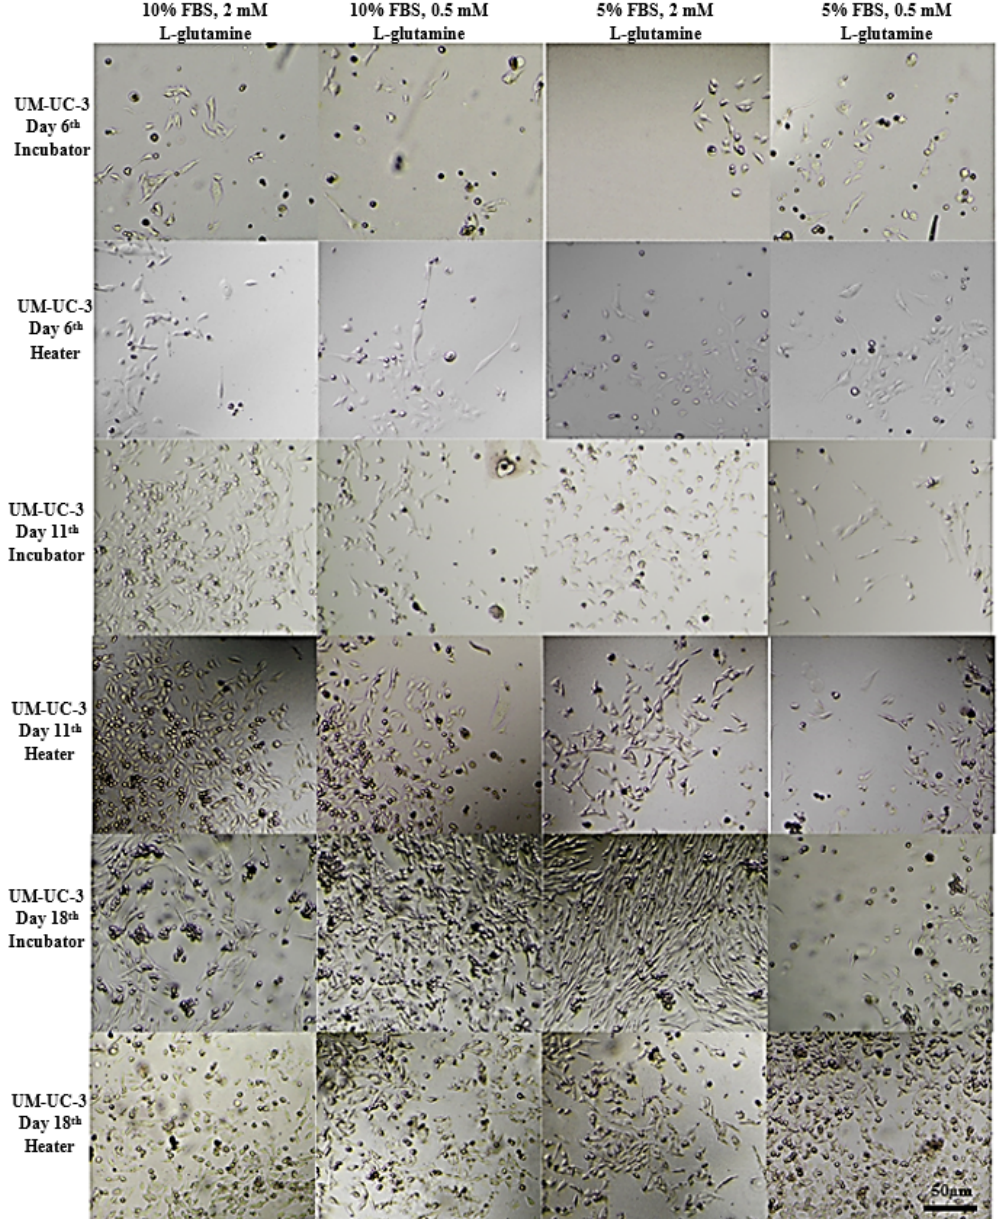
Figure 7. Representative images showing UM-UC-3 cells morphology at given conditions after indicated days of incubation. Incubator 37 °C, 5% CO 2 (standard growth conditions); heater 37 °C.